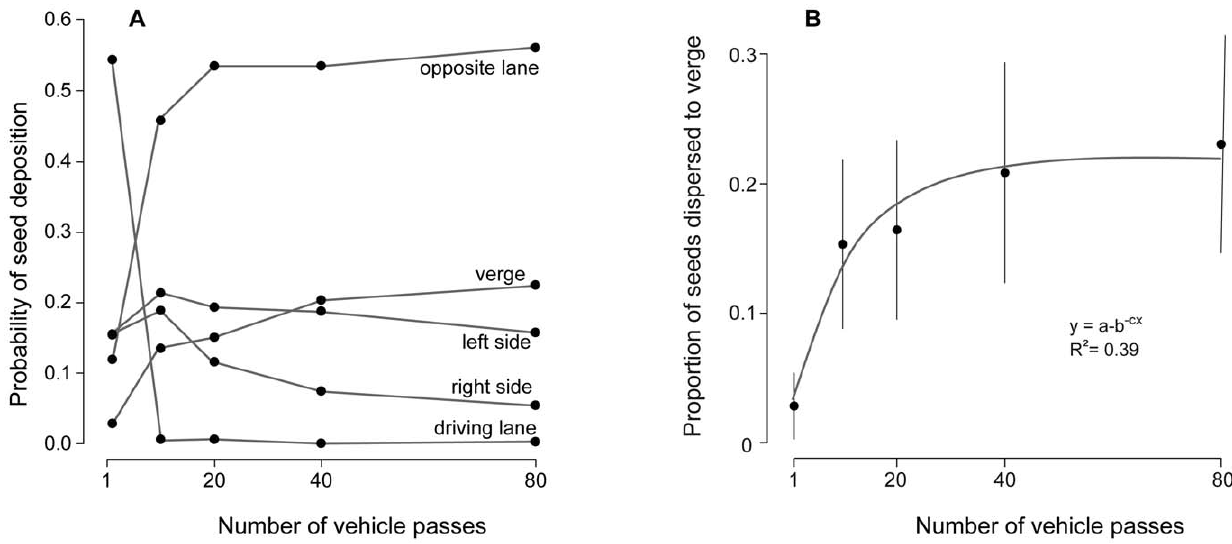
Figure 4. Lateral movement of seeds of Ailanthusaltissima in relation to the number of vehicle passes. (A) Mean probabilities of seed deposition of Ailanthus altissima in the parallel road sections in relation to the number of vehicle passes. (B) Proportion ( 6 95% CI) of seeds of Ailanthus altissima accumulating at the verge in relation to the number of vehicle passes. At the start of experiment seeds were laid out only on the driving lane.